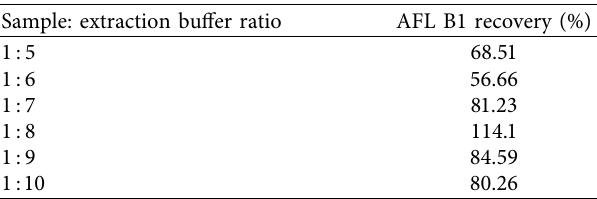
Table 1: Sample/extraction buffer ratio affects the aflatoxin B1 (AFL B1) recovery for corn silage. After pH adjustment (pH � 6.5), an average of parallel measurements is shown (CV% <